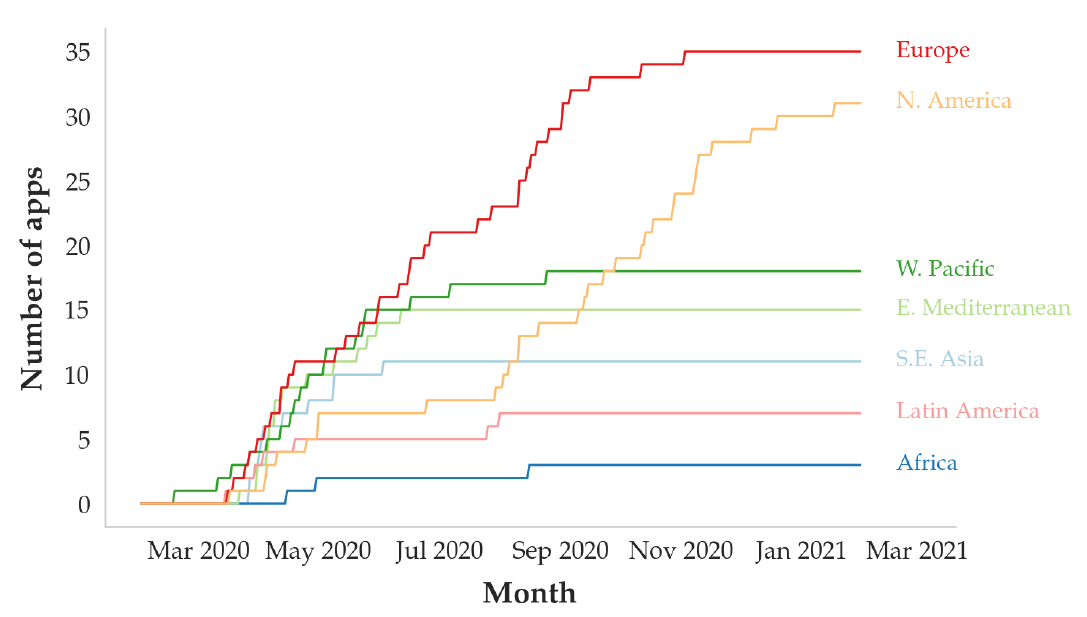
Figure 2. Cumulative number of released contact tracing apps, grouped by WHO region. North America (United States and Canada) is separated from Latin Amer- ica, although normally the WHO groups both into a single Americas region. The total number of apps excludes any apps without a determinate release date (32 excluded). Figure 4 disaggregates the apps by region and protocol. The dominance of the Apple/Google exposure notification protocol later in the pandemic is mainly localized to Europe and North Amer- ica, whereas other regions, such as Southeast Asia, Western Pacific, and Eastern Mediterranean mainly developed apps without a protocol early in the